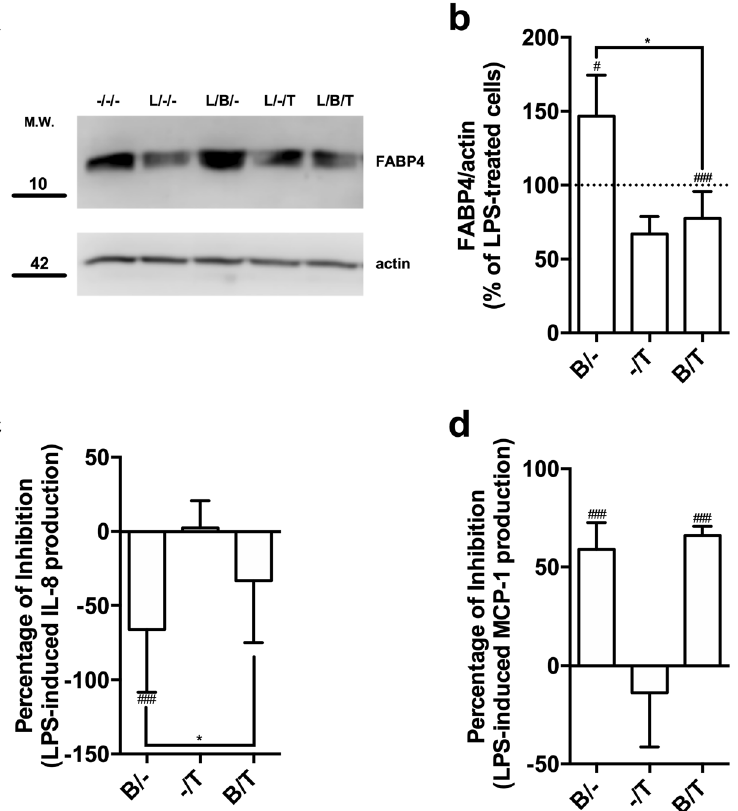
Figure 4. Effect of pharmacological inhibition of PPAR γ on the immuno-modulatory activity of bindarit. ( a ) Representative immunoblot showing the expression FABP4 in MM-6 cells left untreated ( − / − ) or treated with 100 ng/mL LPS (L) for 20 hours, in the absence (L/ − ) or presence of 300 μ M bindarit (B) and 2 μ M T0070907 (T), used alone or in combination (L/B − an L/B/T). Protein lysates were subjected to immunoblotting following 10% SDS-PAGE against the anti-FABP4 antibody. Actin was also probed with anti-actin antibody to confirm equal protein loading. Molecular weights (M.W.) of protein markers (in kDa) are shown on the left side. ( b ) Bar graph of the densitometric analysis of 5 independent experiments. The results were normalized with respect to the actin signal, and were reported as percentage of increase ( ± S.D.) with respect to the normalized value of the treatment with LPS. Significance is shown as P value calculated using a one-sample t -test. # P < 0.05 vs LPS (set to 100%). ### P < 0.001 vs LPS. * P < 0.05. Inhibition of the production of IL-8 ( c ) and MCP-1 (d )